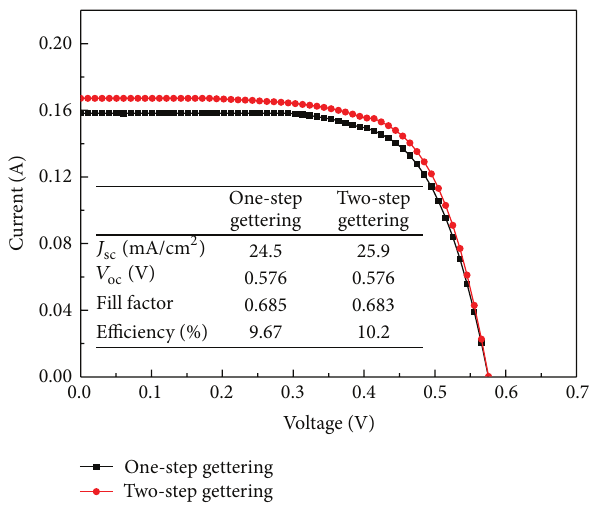
Figure 7: I - V characteristics of the UMG-Si solar cells processed with one- and two-step gettering. The increase in the cell efficiency due to two-step gettering was 0.53% compared with that from one- step